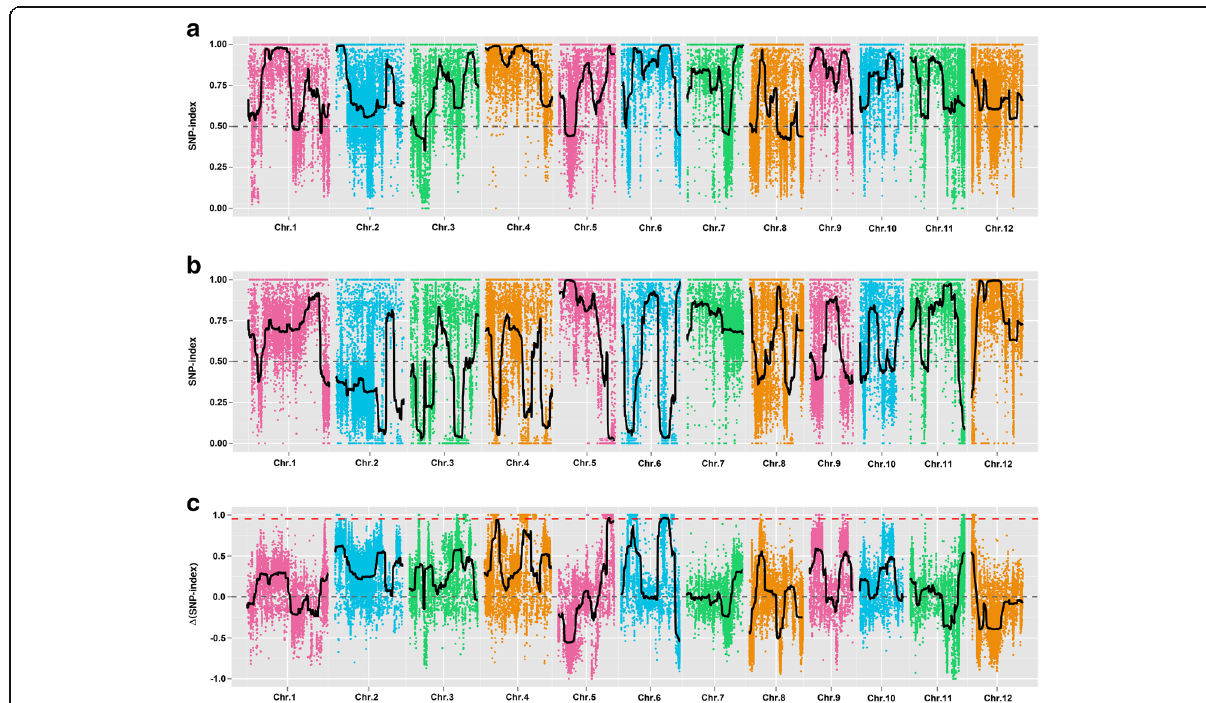
Fig. 3 Identification of the hot-region for PSST through the SNP-index association analysis method. X-axis represents the position of 12 chromosomes of rice and Y-axis represents the SNP-index or Δ (SNP-index). The color dots represent the SNP-index or Δ (SNP-index) value of every SNP locus. The black lines show the SNP-index or Δ (SNP-index) value of fitting results. a: the SNP-index graph of T-pool. b: the SNP-index graph of S-pool. c: the Δ (SNP-index) graph. The red dotted line shows the association threshold value (0.9532)